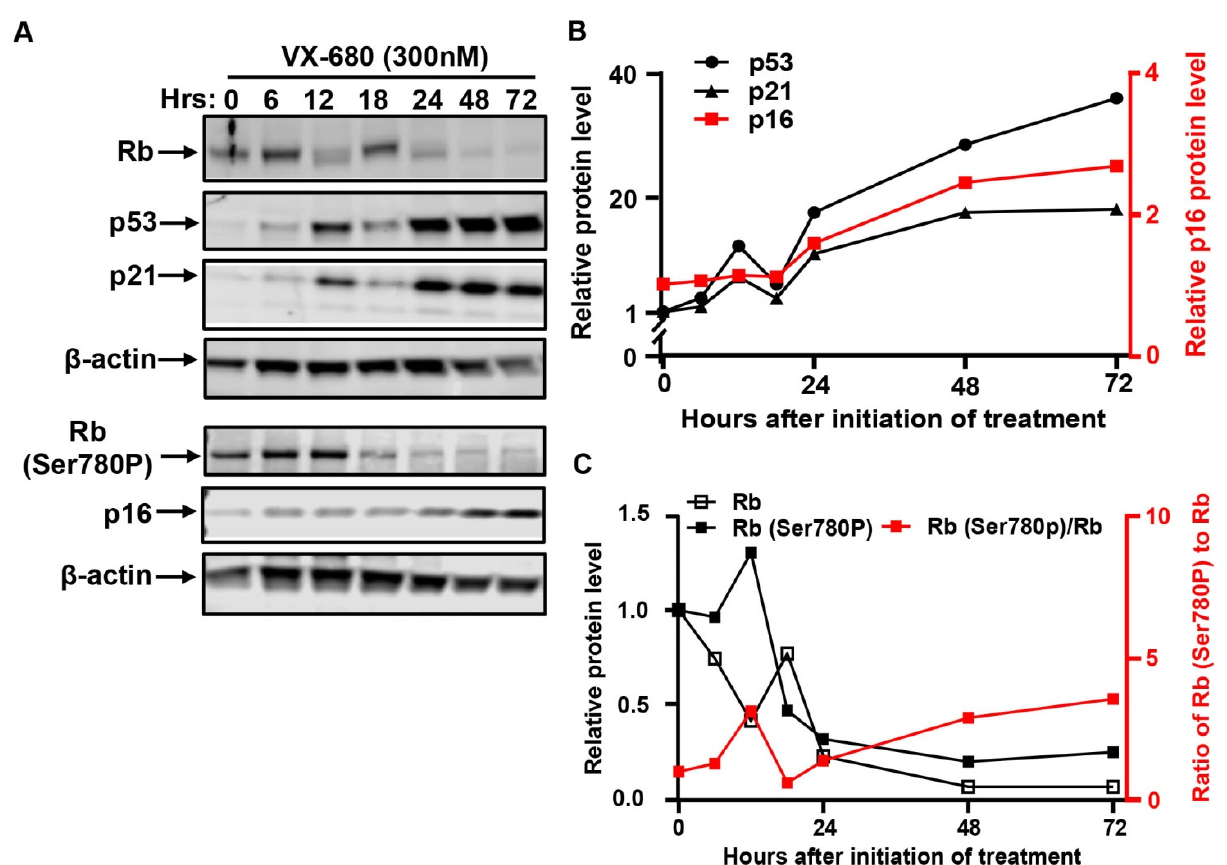
Figure 2. VX-680 activates the p53-mediated checkpoint pathway but not the tumor suppressor Rb. RPE-NEO cells were exposed to 300 nM of VX-680 for three days. Cells were collected at the indicated time points after the initiation of drug treatment for the analysis of the indicated proteins by Western blot. The blots were cropped, and the full-length original blots are presented in Supplementary Figure S4B,C. Quantification of p53, p21, and p16 in ( A ) is presented in ( B ). Quantification of total Rb, Rb phosphorylated at Ser780, and the percentage of Rb phosphorylation at Ser780 is shown in ( C ). A representative experiment is shown. Western blot was performed in two independent experiments. The quantification of a representative experiment in A has been presented in B and C. Two independent experiments produced the same trend.